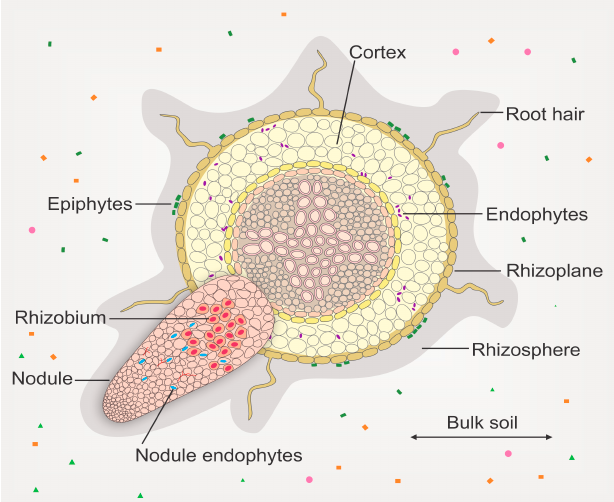
Figure 2. The complexity of bacterial root microbiota. The bacterial community decreases in complexity from the rich soil microbiota to the rhizosphere, the rhizoplane, the endosphere, and the nodule. The rhizosphere is colonized by a subset of the bulk soil community, and the rhizoplane hosts epiphytes that are firmly attached to the root surface. The endosphere (root interior) is inhabited by endophytes. The root nodule is the habitat of symbiotic nitrogen-fixing bacteria, known as rhizobia, and also harbors a diversity of non-fixing bacteria called nodule endophytes. Infection threads can be coinhabited by endophytes and rhizobia.